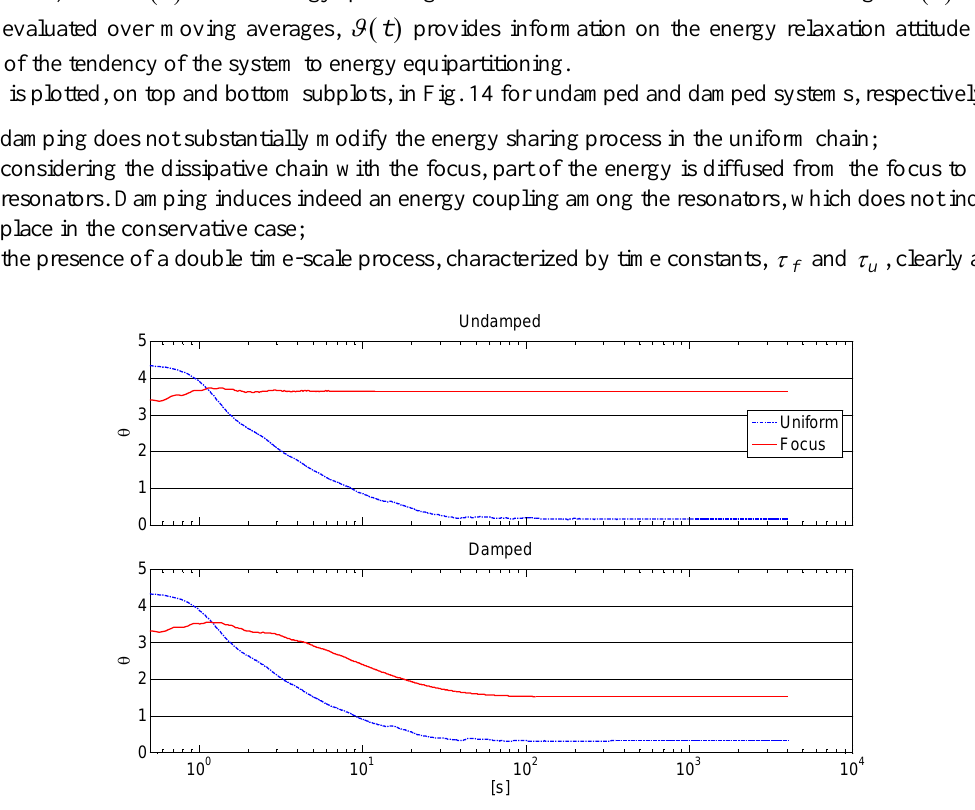
Fig. 14. Energy coupling index versus time, x, y axes in log scale, for undamped and damped systems, in subplot on top and bottom,